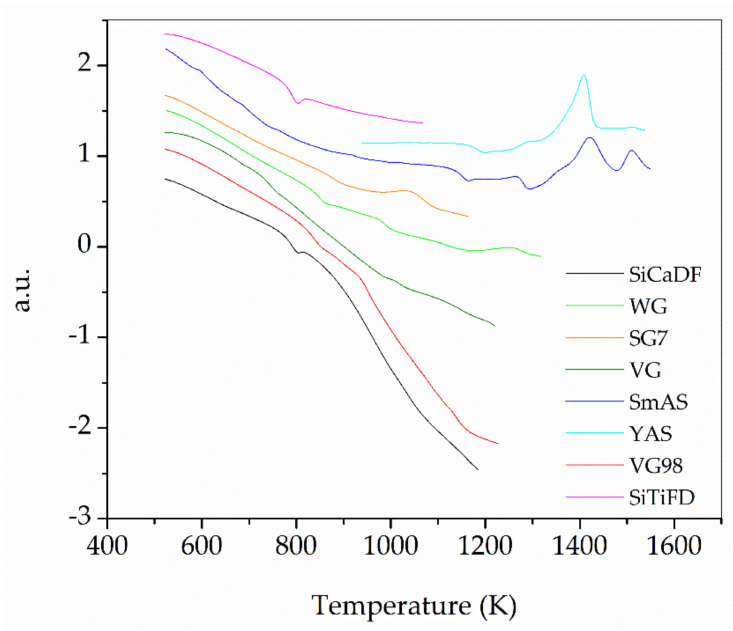
Figure 6. DTA traces measured for all of the glasses in this work. Lines were translated vertically to avoid crossings over each other.